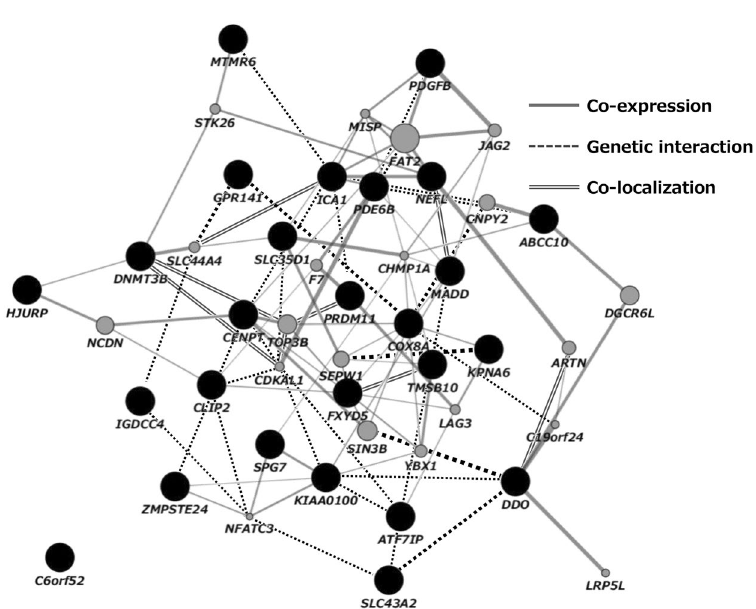
Figure 3. Gene network analysis using GeneMANIA. Dark circles represent genes associated with the 26 DMPs found to be related to BPA exposure in the male-only analysis. Light circles represent additional genes predicted by GeneMANIA based on genetic and physical